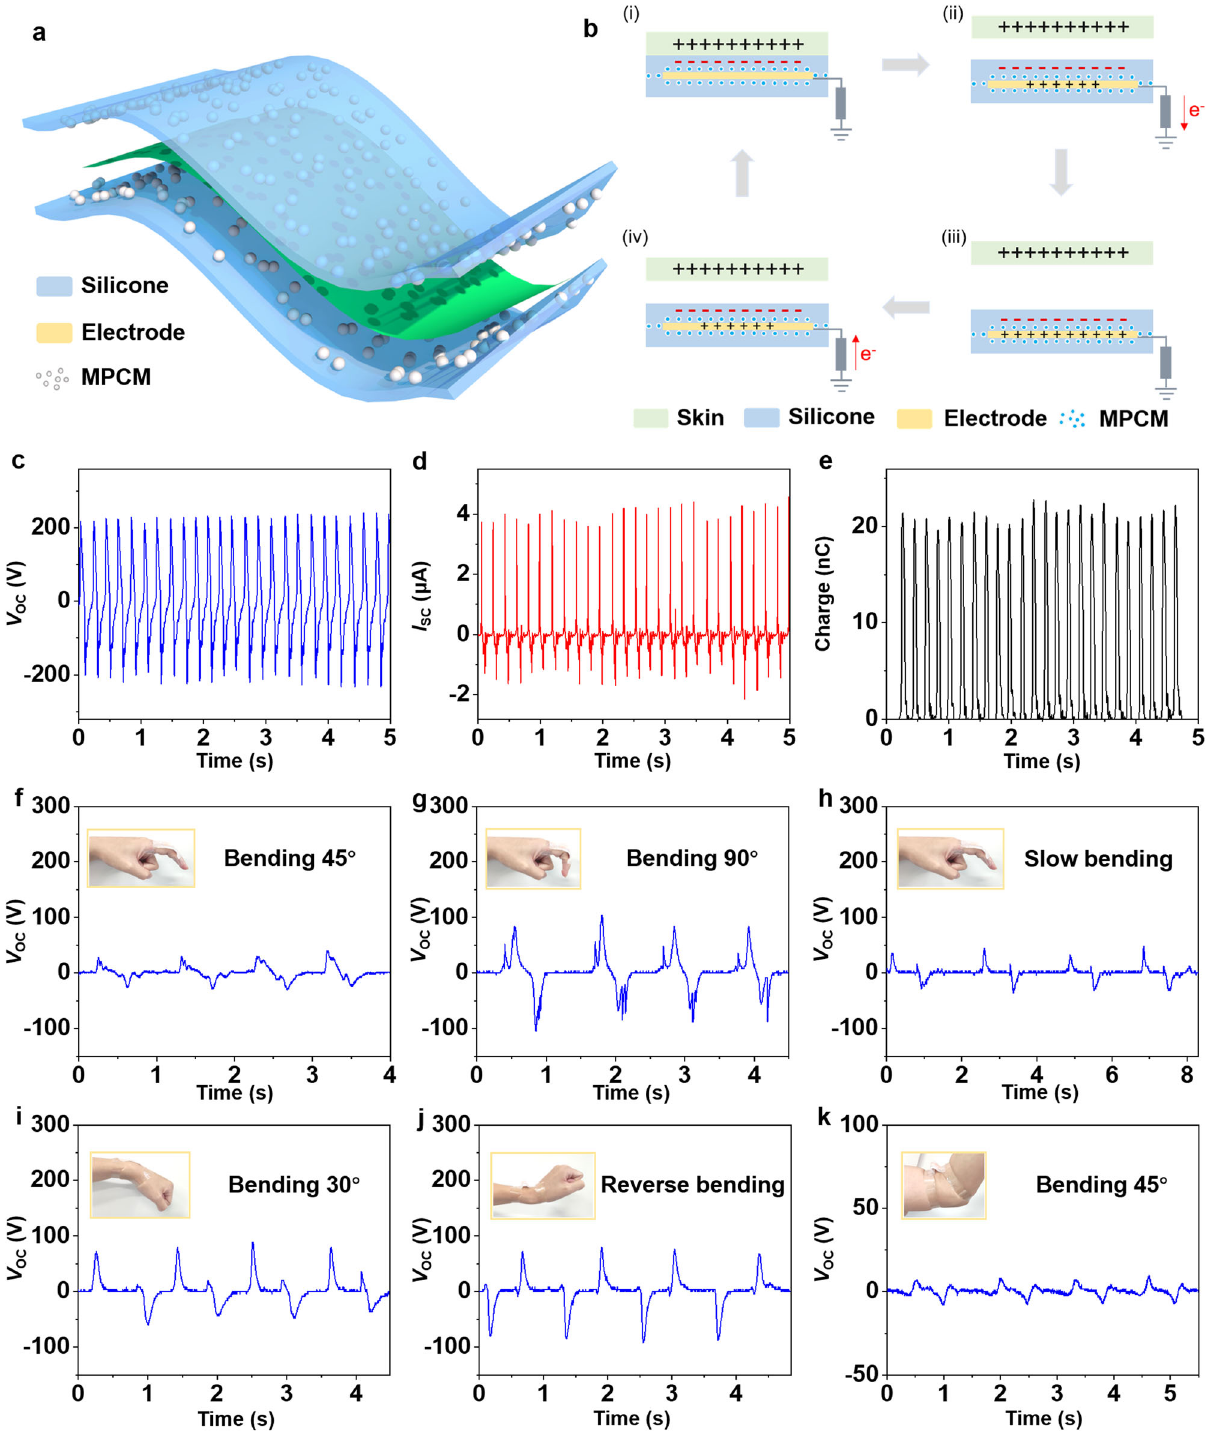
Fig. 3 The electrical output performance of ME-skin for human motion monitoring. a The schematics diagram of ME-skin. b The working mechanism for ME-skin in a contact-separation mode. c – e The open-circuit voltage, short-circuit current and transferred charge of tapping ME-skin with a hand. f – h Fixing ME-skin on a fi nger, the open-circuit voltage of bending the fi nger 45°, 90°, and bending slowly 45°. i , j The open-circuit voltage of bending the wrist 30° forward i and reverse when ME-skin was fi xed on the wrist. j , k Fixing ME-skin at the arm, the open-circuit voltage with bending the arm 45° contact and separation between hand and ME-skin were peak short-circuit current of 3.82 μ A are obtained by tapping a dif fi cult to be completely symmetrical. Consequently, the 5 × 5 cm ME-skin with the palm of your hand. The correspond- positive and negative of open circuit voltage and short-circuit ing transfer charge is 20.3 nC, which is acquired by integrating current signal were also not symmetrical. the current signal, as plotted in Fig. 3e. The two processes of